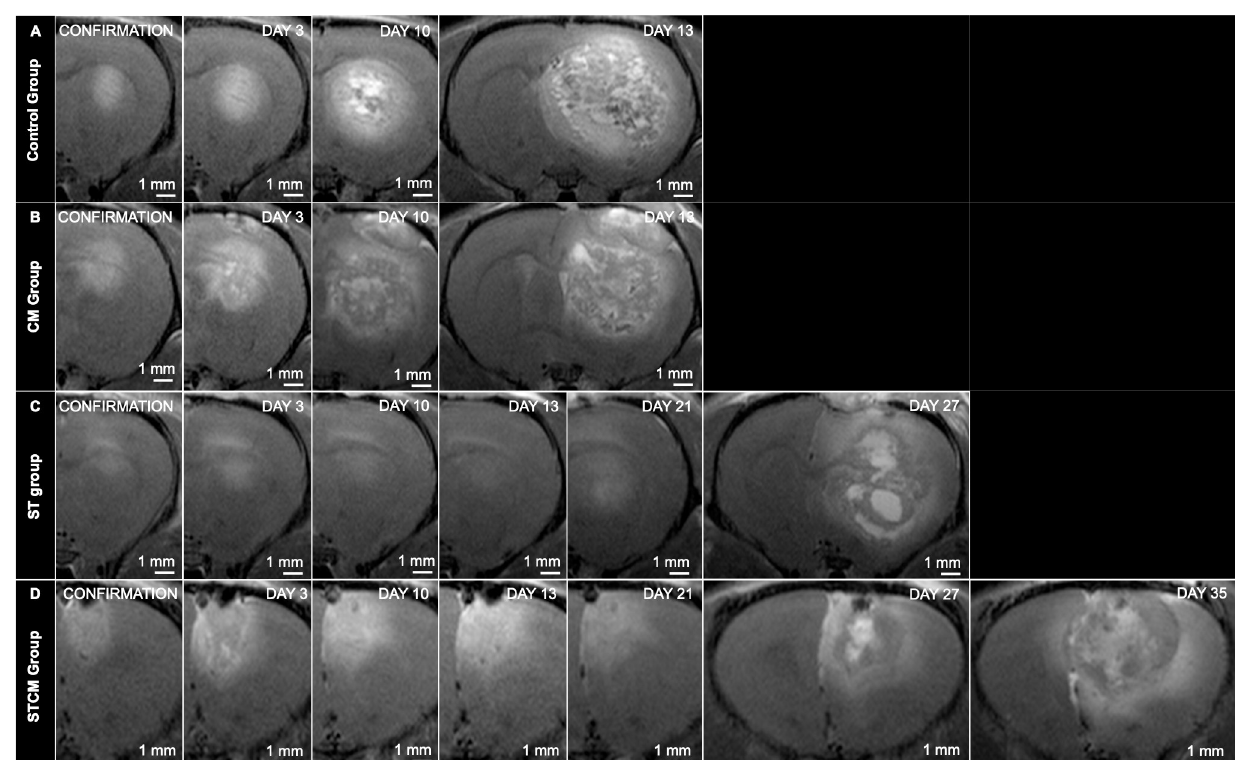
Fig 3. MR imaging of GB growth per treatment group. In vivo serial CE-T1w MRI scans in the same rat showing GB growth in the four treatment groups.